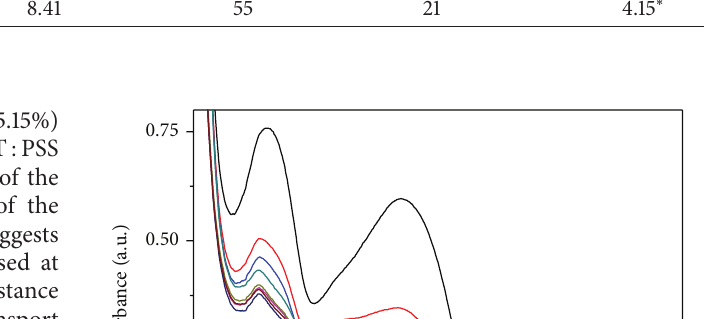
Table 4: 𝐽 - 𝑉 parameter of OTFSCs device of PCDTBT:PC layer.